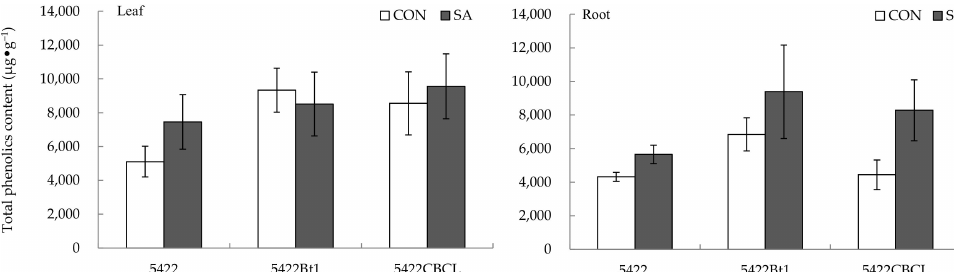
Figure 3. Direct and systemic effects of exogenous salicylic acid application to the aboveground part on the content of total phenolics in leaves and roots of conventional and Bt corns. The data in the figure are means ± standard errors. Significance among the data was determined by paired Student’s t -test. CON: control; SA: salicylic acid.